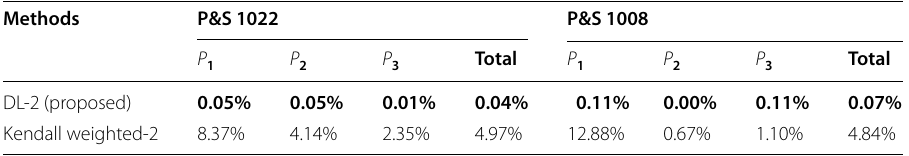
Table 2 Error probability of pattern recognition, when the model of printers used for training and testing database is different